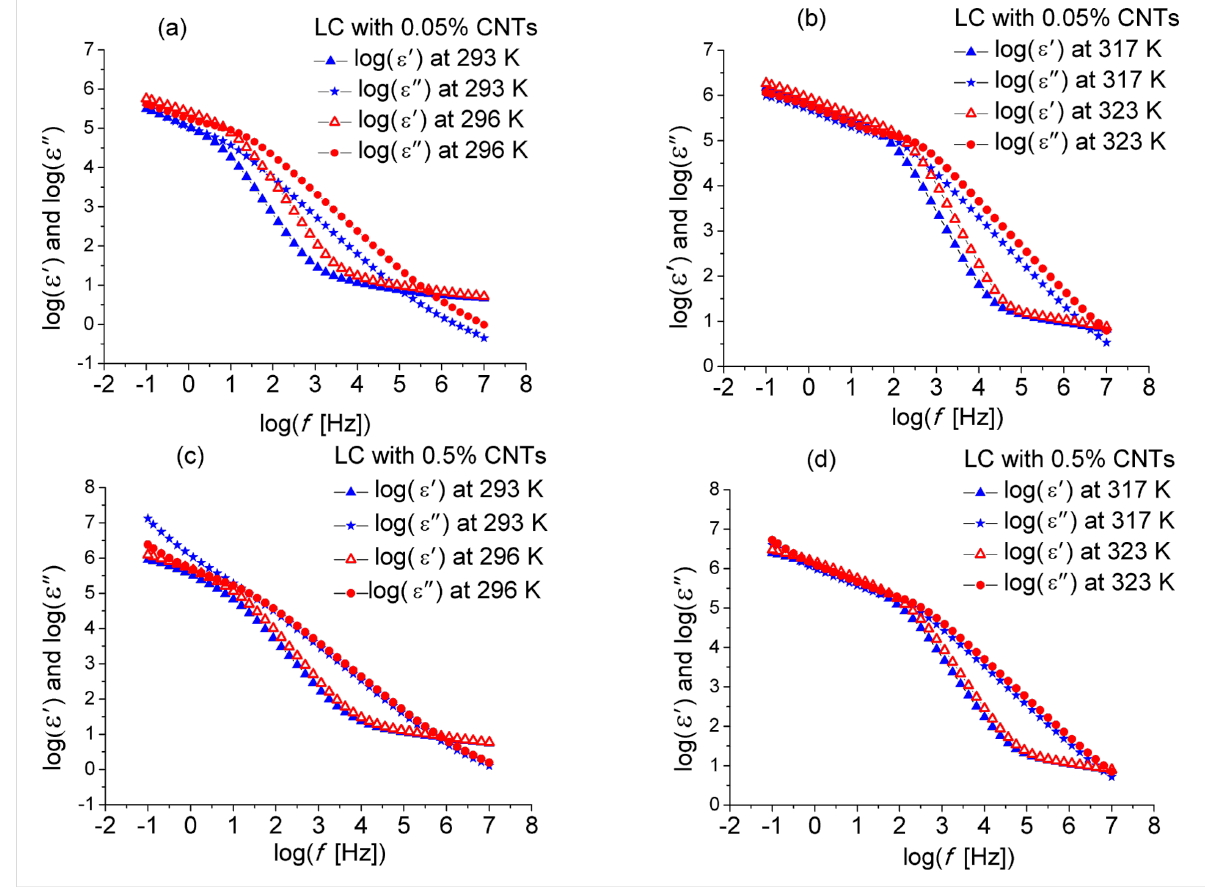
Figure 9: Permittivity and dielectric loss as functions of the frequency (logarithmic scale) at different constant temperatures for (a,b) ILC with 0.05% CNTs, and (c,d) ILC with 0.5% CNTs.